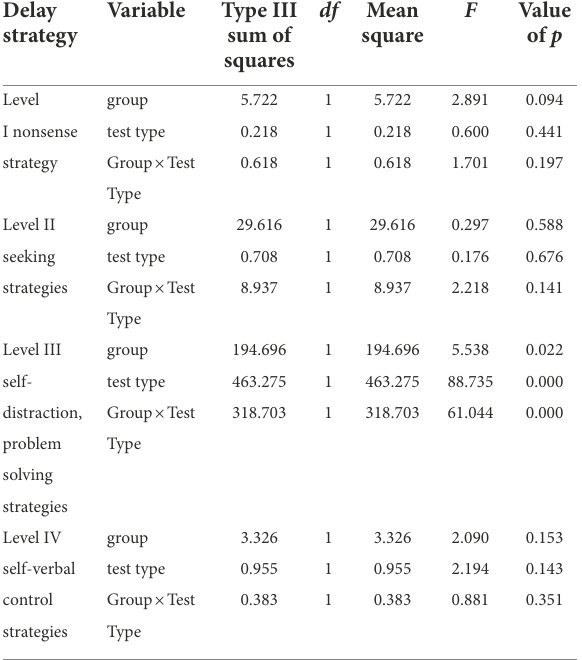
TABLE 6 Analysis of variance results of different levels of children’s delay strategy scores in different